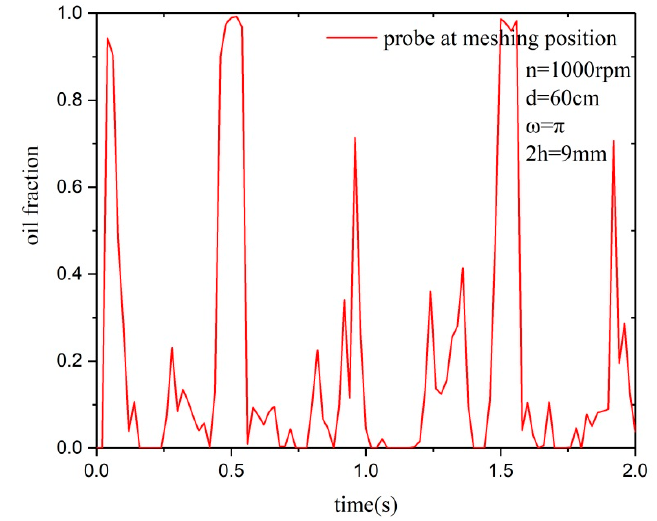
Figure 11. Oil flow field and velocity distribution inside the gearbox ( n = 1000 rpm).